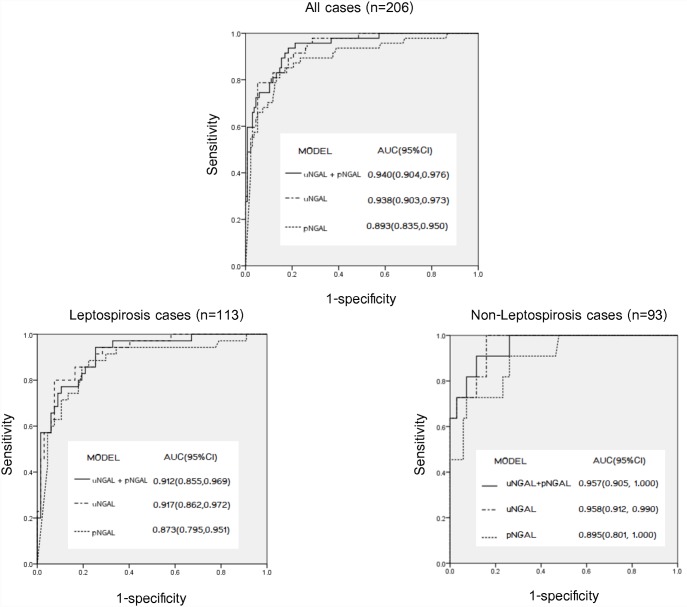
The area under the curve (AUC) for the association between biomarkers and AKI: pNGAL alone, uNGAL alone, and combined model.